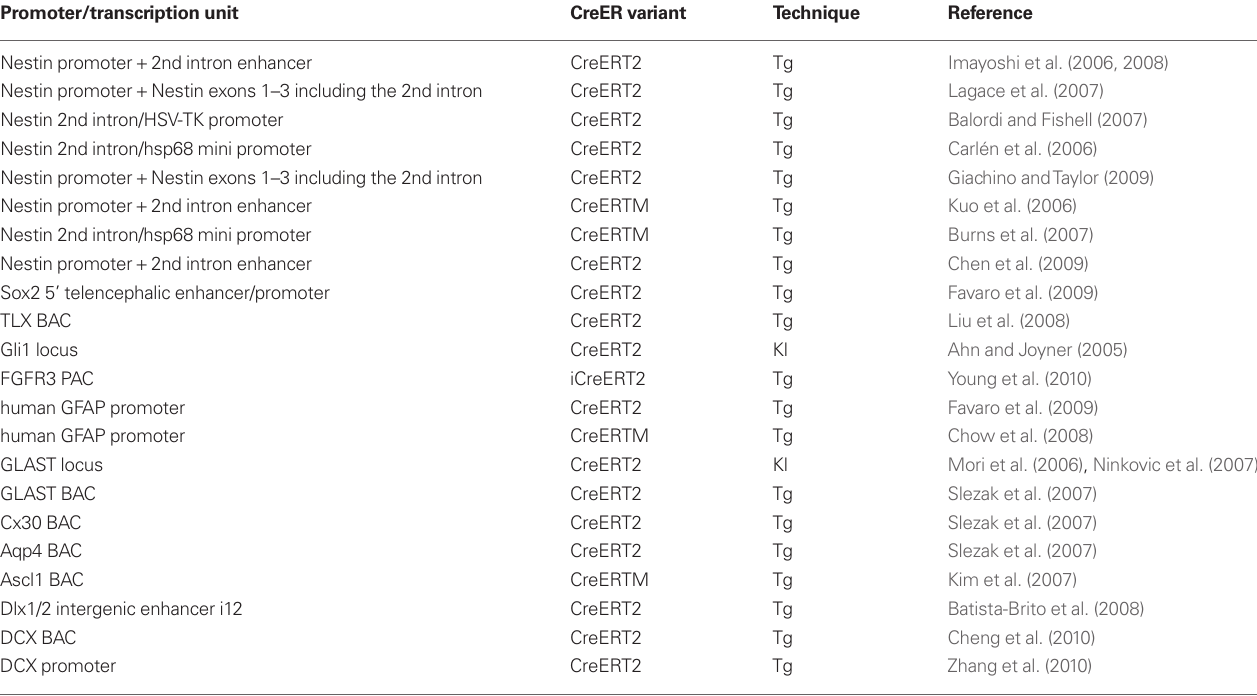
Table 1 | CreER-expressing mice for Cre/loxP gene targeting in adult neurogenesis research. Promoter/transcription unit CreER